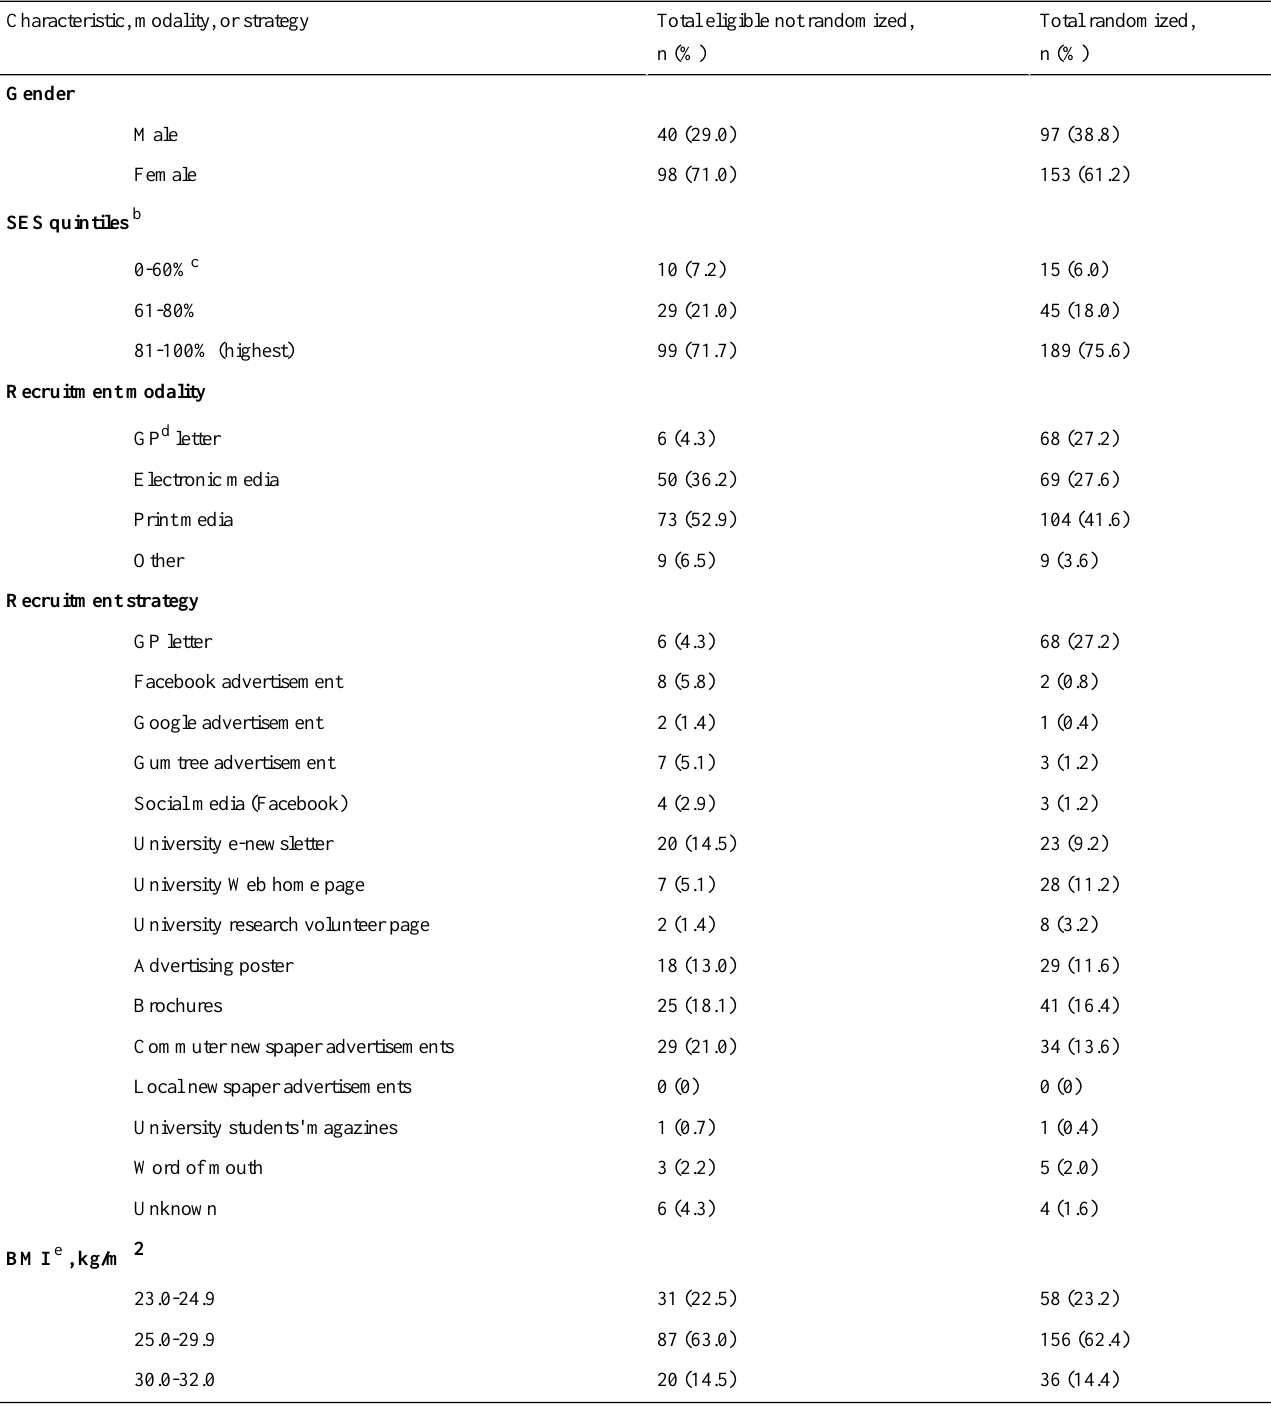
Table 6. Baseline health characteristics, recruitment modalities, and strategies of eligible participants who did not participate in the TXT2BFiT study (n=138) versus randomized participants (n=250) a